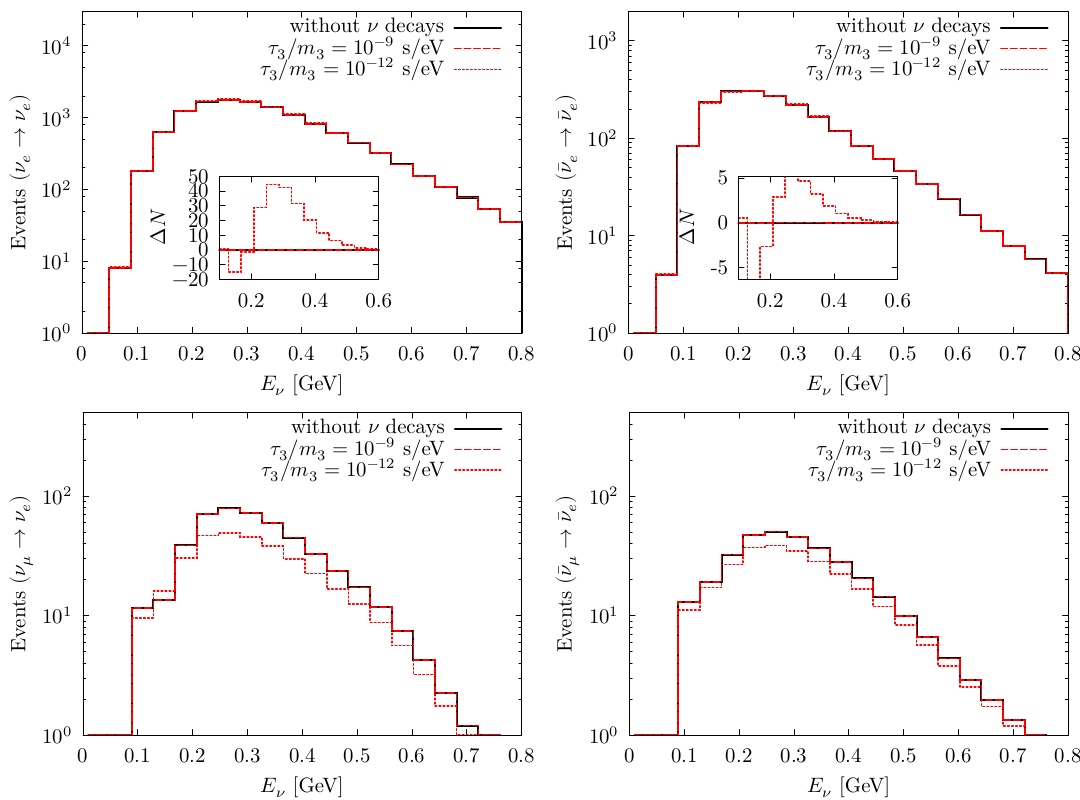
Figure 4 . The spectra with (cid:28) 3 =m 3 = 10 (cid:0) 12 s/eV (red-dotted) and = 10 (cid:0) 9 s/eV (red-dashed) and under the standard model (black) for MOMENT. Four channels are considered: (cid:23) e ! (cid:23) e (upper- left), (cid:22) (cid:23) e ! (cid:22) (cid:23) e (upper-right), (cid:23) (cid:22) ! (cid:23) e (right-left), and (cid:22) (cid:23) (cid:22) ! (cid:22) (cid:23) e (lower-right). The oscillation baseline is set at 150 km. For clearness, in the result for the (cid:23) e and (cid:22) (cid:23) e disappearance channels, we